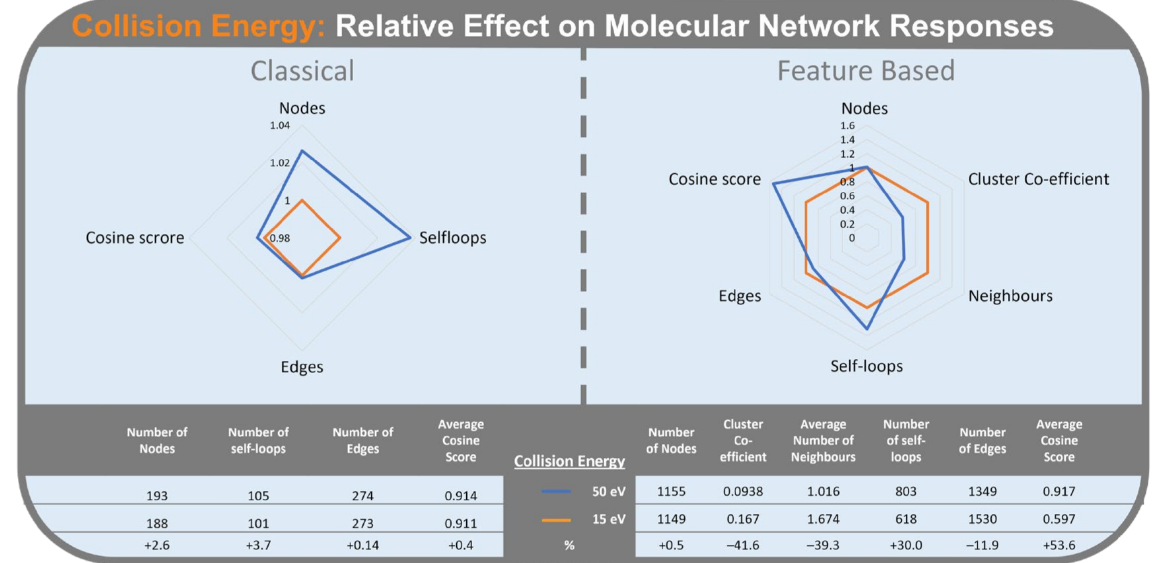
Figure 7. Radar graph of collision energy effect (15 eV in orange) (50 eV in blue) on the relative change of responses. Classical Molecular Networking ( left ) and Feature-Based Molecular Network- ing ( right